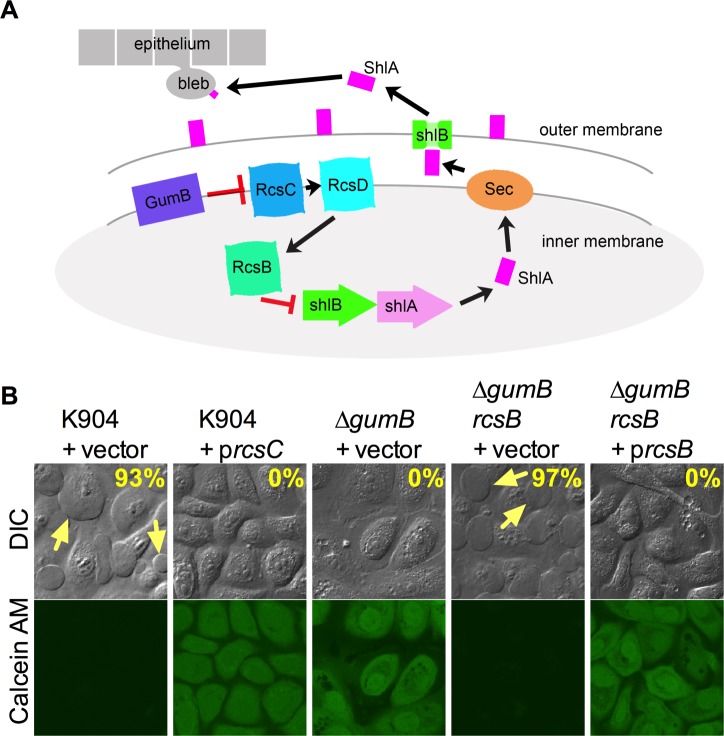
GumB regulation of bleb formation and cytotoxicity requires the Rcs signaling system.(A) Model for the regulatory circuit through which GumB functions to regulate epithelial cell bleb formation, based on this study and DiVenanzio, et al [58]. GumB inhibits (red stop bar) the Rcs-phosphorelay system through which the response regulator RcsB inhibits shlBA expression. The ShlA cytolysin is secreted through the outer membrane by ShlB and is maintained on the bacterial outer membrane or released into the environment where it can form pores in mammalian cell membranes and stimulate bleb formation and cellular death. (B) Confocal micrographs of HCLE cells imaged with differential interference contrast (DIC) and calcein AM viability stain after exposure to bacteria for 2 h at MOI = 50. Yellow arrows indicate blebs extending from corneal cells. Multicopy expression of the rcsC histidine sensor kinase gene confers gumB-like phenotypes to the wild type (prcsC = pMQ514). The ΔgumB mutant bleb-phenotype is suppressed by mutation of the rcsB response regulator gene, and this effect can be complemented by the wild-type rcsB gene on a plasmid (prcsB = pMQ614).